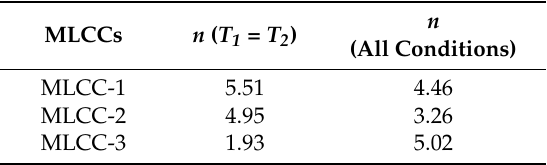
Table 4. Voltage stress constant ( n